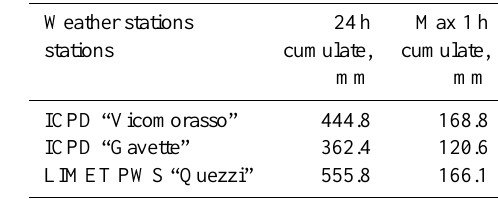
Table 2. The maximum precipitation depth in 1h, 24h precipitation cumulate registered by LIMET PWS “Quezzi” and nearest ICPD weather